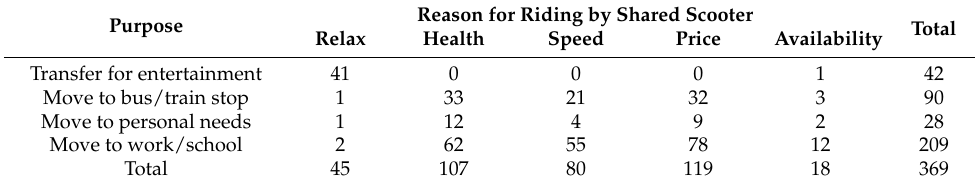
Table 7. The reason for using shared